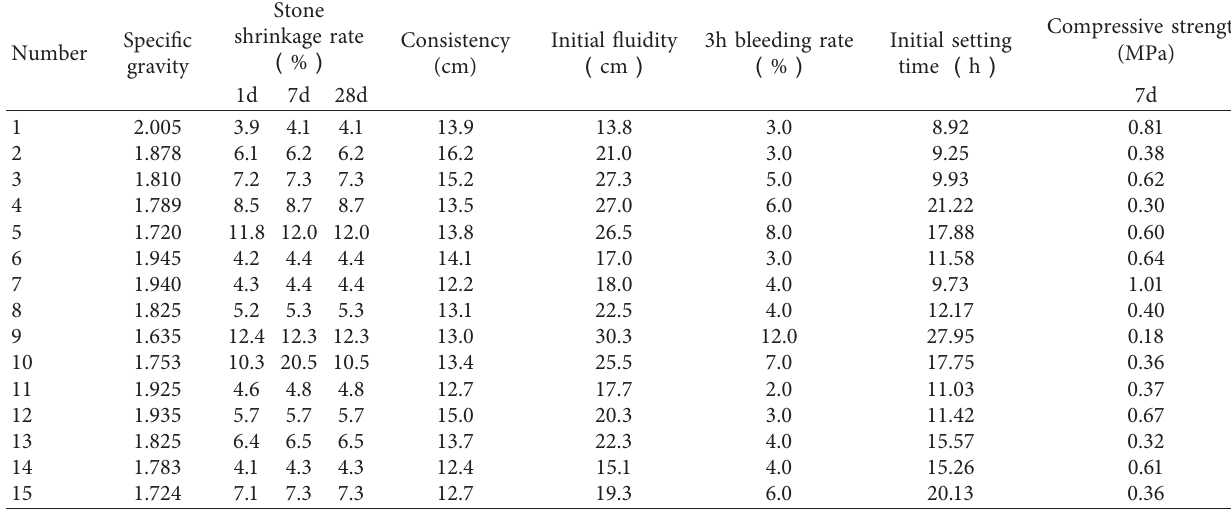
Table 5: Test results.